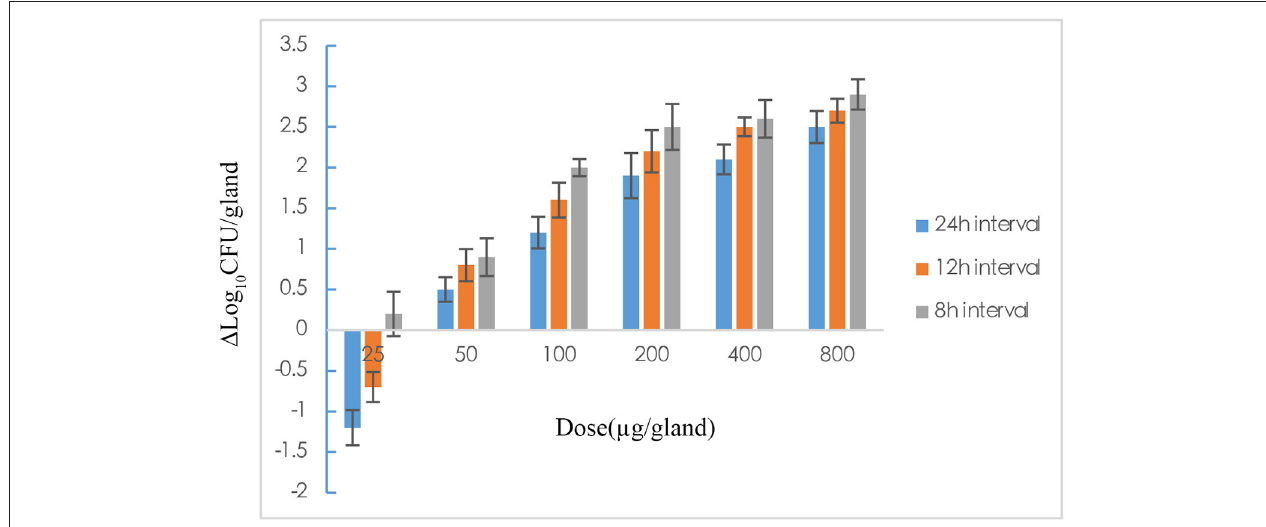
FIGURE 3 | The effect of rifaximin on mastitis induced by Staphylococcus aureus in mouse after 18 dose regimens designed with 25, 50, 100, 200, 400, and 800 µ g/gland and dosing intervals 8, 12, and 24h, which was expressed as 1 log l0